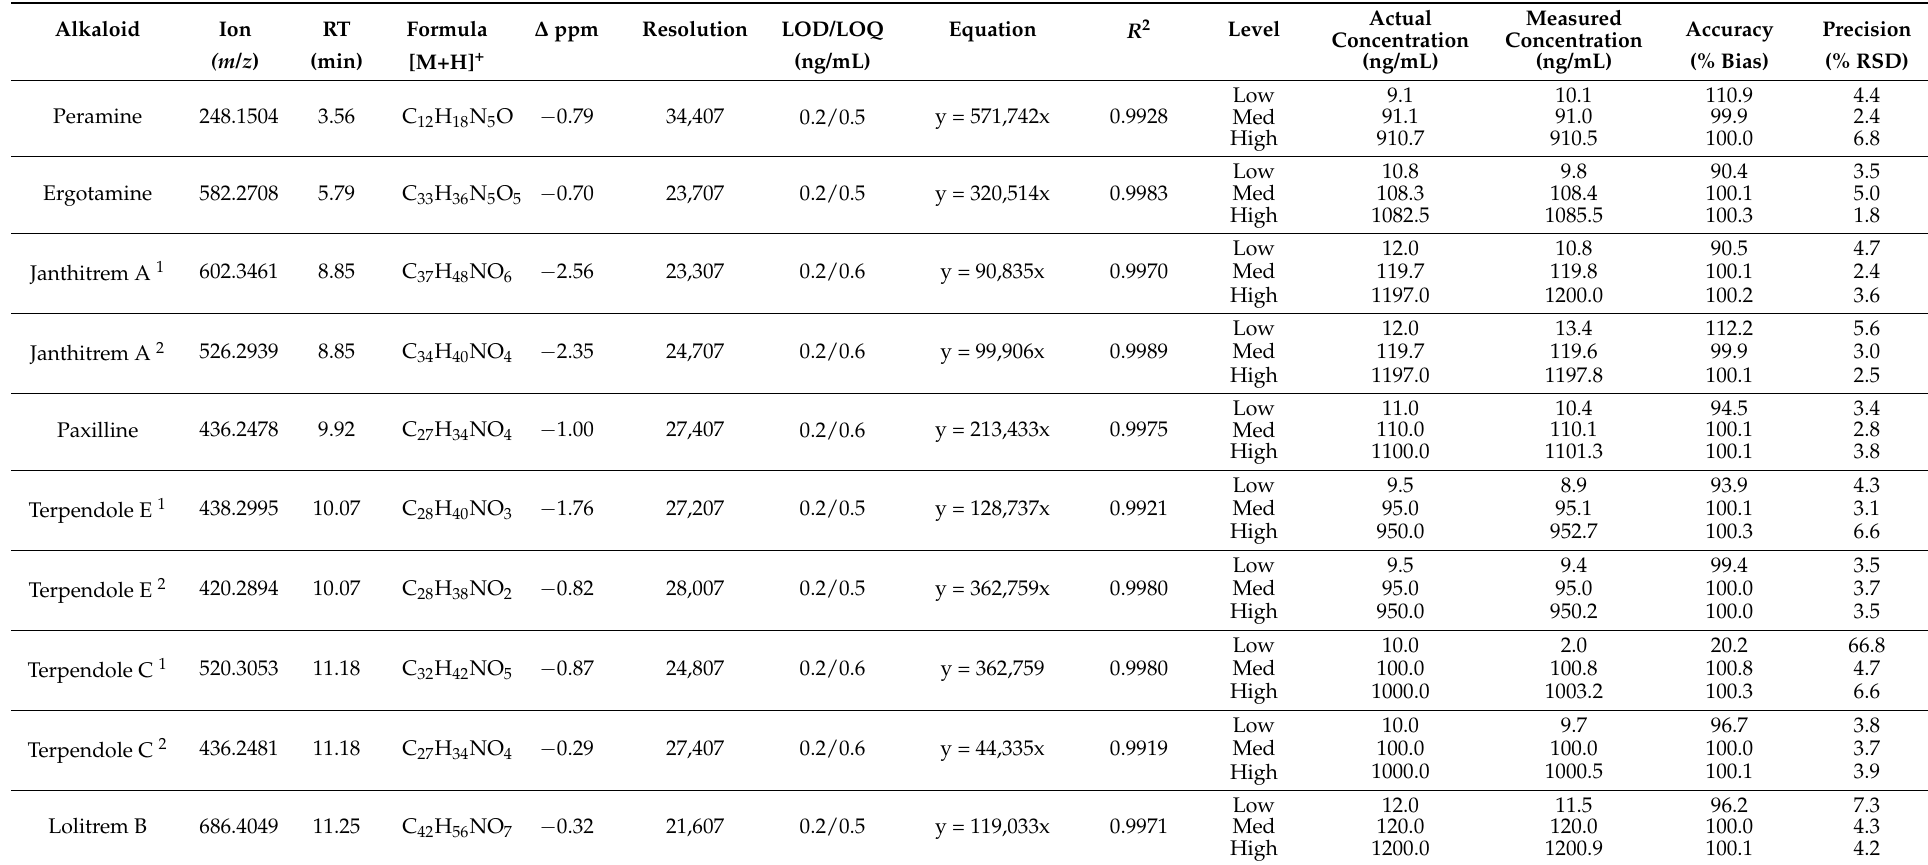
Table 2. LOD, LOQ, linearity, accuracy (bias) and precision for each of the alkaloid standards at low, medium and high